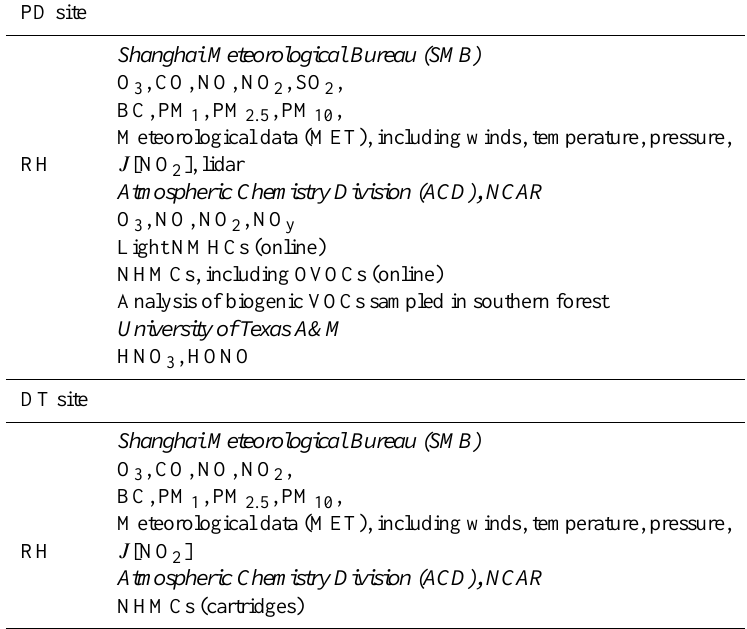
Table 1. List of institutions and instruments deployed at the PD and DT